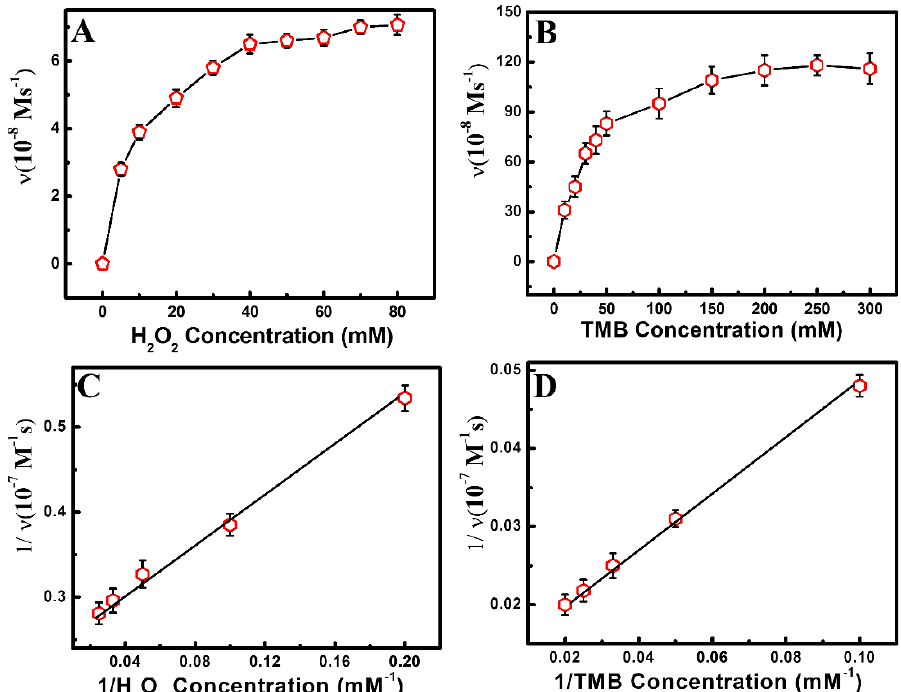
Figure 4. Kinetic study of Au QDs: ( A , C ) 5 mM TMB with various concentrations of H 2 O 2 , ( B , D ) 10 mM H 2 O 2 with various concentrations of TMB.